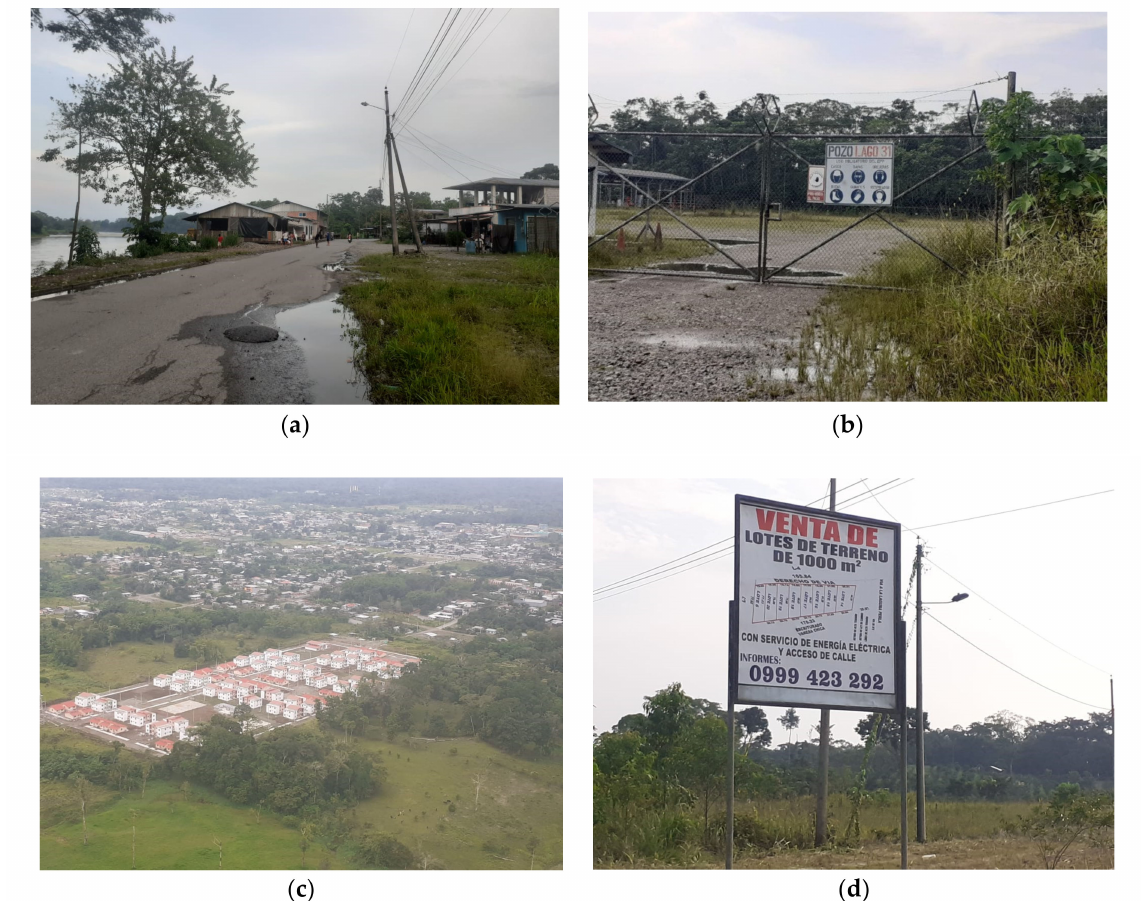
Figure 5. Urban realities associated with the urban regions calculated: ( a ) region 3: A consolidated neighborhood disconnected with the city of Lago Agrio; ( b ) region 3: A neighborhood located in the northeast of Lago Agrio and close to an oil platform; ( c ) region 1: A new public housing development; and ( d ) region 1: A recent private